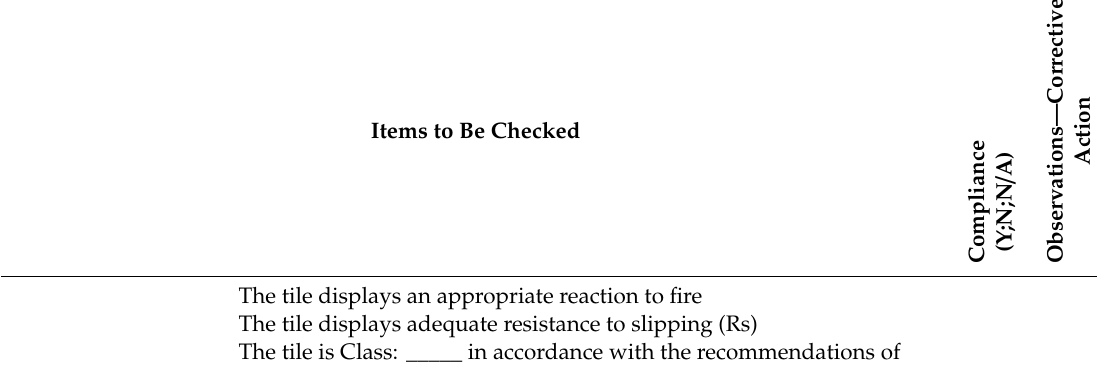
Table 3. Monitoring sheet for incoming materials for ceramic